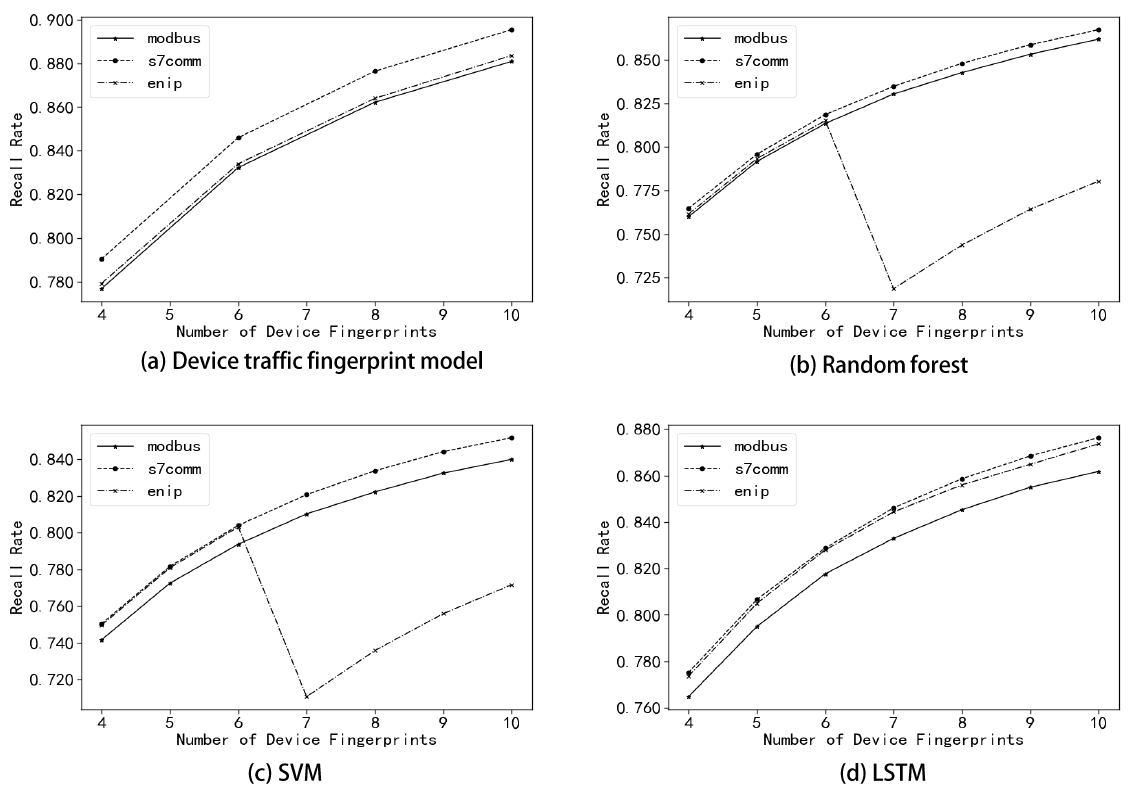
Figure 14. Recall curves of the four